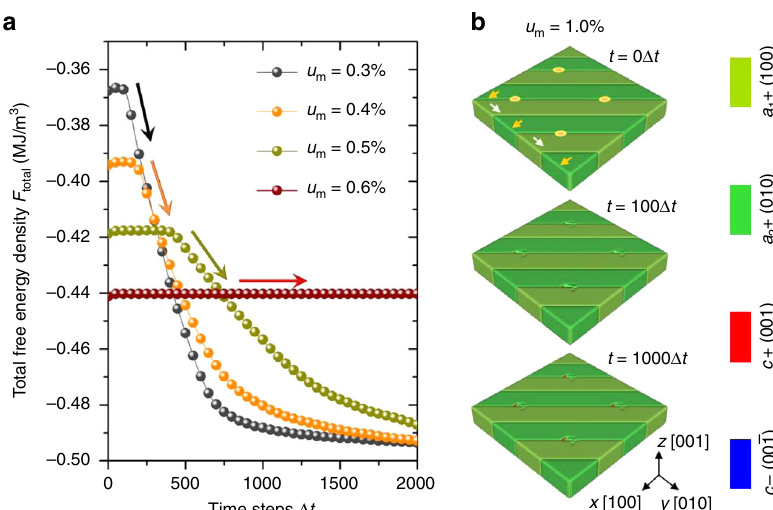
Fig. 5 Phase- fi eld simulation of domain evolution under various strain states. a Total free-energy density changes after the probe tip-induced force exerted on an initially pure a 1 / a 2 domain structure of the fi lms subjected to various tensile strains ranging from + 0.3% to 0.6%. The corresponding arrows indicate the steepness of the energy changes. b Phase- fi eld simulations of mechanical force-induced domain evolution of the fi lms with a 1 / a 2 domains subjected to 1% tensile strain. Probe tip force locations are noted by four circles on the fi lm